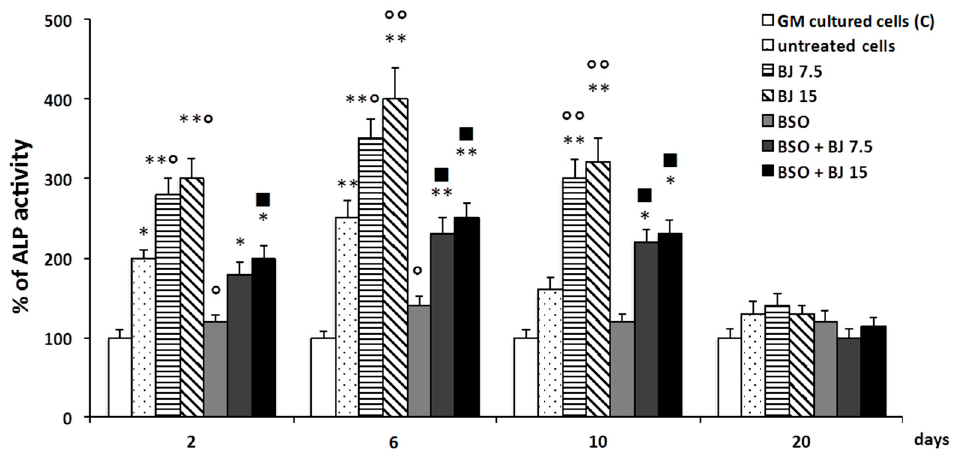
Figure 2. BJ effect on alkaline phosphatase (ALP) activity during differentiation of BSO-treated and untreated SaOS-2 cells. ALP activity, detected by the QuantiFluo Alkaline Phosphatase Assay Kit, was measured in SaOS-2 cells treated or untreated with BJ, containing 7.5 or 15 µ g · mL − 1 total soluble polyphenols (TSP), or BSO or BSO + BJ for one day in growth medium (GM). Subsequently, untreated cells were cultured in GM (C; control) for two, six, 10, or 20 days and, for the same times, treated and untreated cells were cultured in osteogenic medium (OM), as reported in Section 2 . ALP activity is expressed as a percentage of the respective C values, and these are the means ± SEM of four experiments performed in triplicate; * p ≤ 0.05, ** p ≤ 0.001 compared to C cells; ○ p ≤ 0.05, ○○ p ≤ 0.001 compared to untreated cells; ■ p ≤ 0.05 compared to BSO-treated cells.